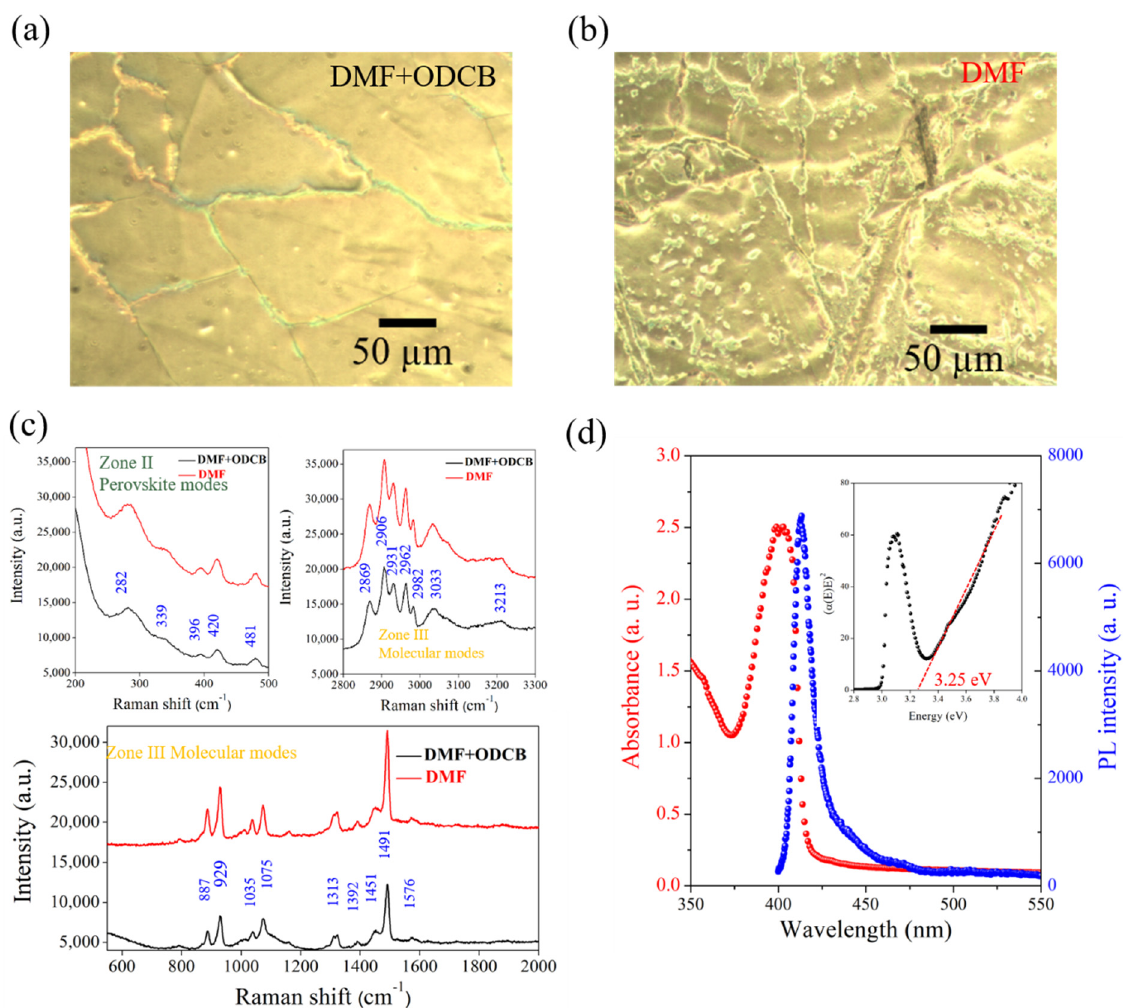
Figure 5. Surface morphology of (C 4 H 9 NH 3 ) 2 PbBr 4 2D perovskite observed by OM images using ( a ) an ODCB/DMF co-solvent or ( b ) a DMF single-solvent system. ( c ) Raman and ( d ) absorption spectra (red) and PL emission (blue) of (C 4 H 9 NH 3 ) 2 PbBr 4 2D perovskite film fabricated by single- and co-solvent processes. The inset shows the Tauc plot from the absorption spectra of (C 4 H 9 NH 3 ) 2 PbBr 4 2D perovskite with a band gap of 3.25 eV from extrapolation to the energy axis.